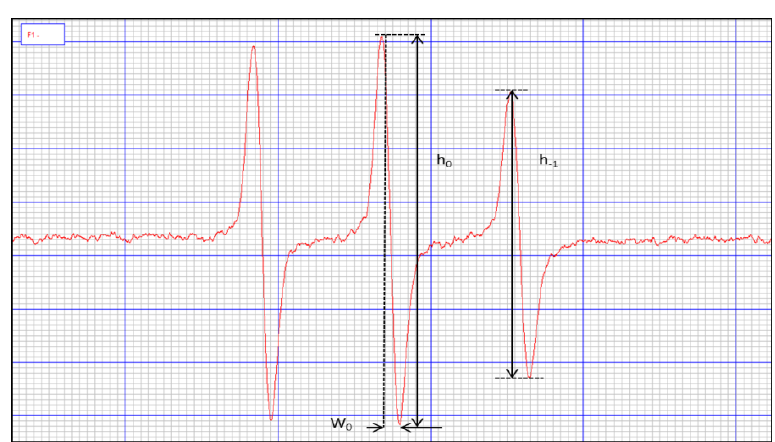
Figure 5. View of Tempamine marker.